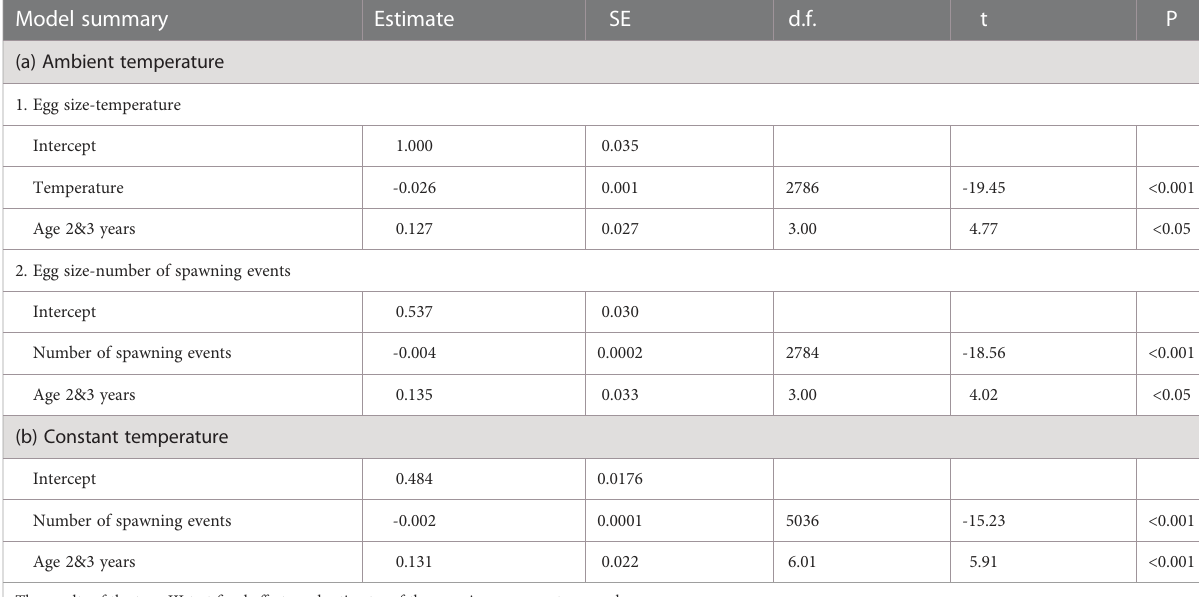
TABLE 1 Summary table for linear mixed-effects model estimates fi tted using restricted maximum likelihood for the effect of temperature, number of spawning events, and maternal age (ages: 1 year and 2 and 3 years) on egg size (mm 3 ). Model